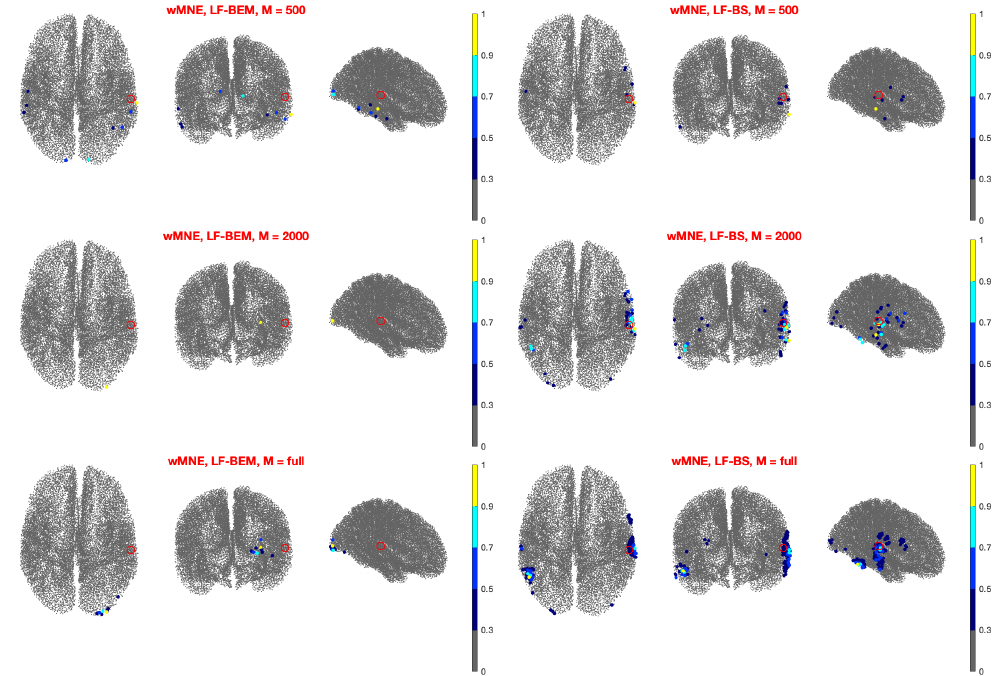
Figure 7. Left Auditory evoked field: The intensity of the estimated sources, averaged over N = 10 runs, at 90 ms obtained using wMNE with M = 500 random points (first row), M = 2000 (second row) and the full source space (third row) for LF-BEM (left column) and LF-BS (right column). The red circle represents the dipole fitted using